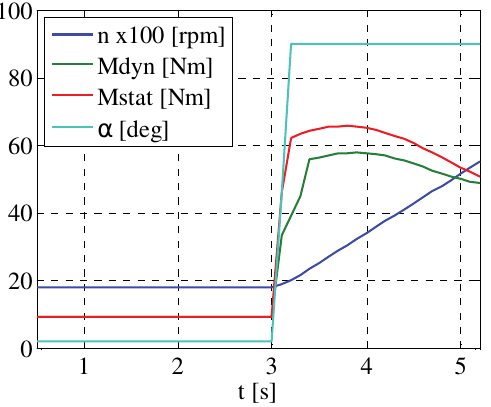
Fig. 13. Engine parameters during full throttle opening lasting 0.2 s